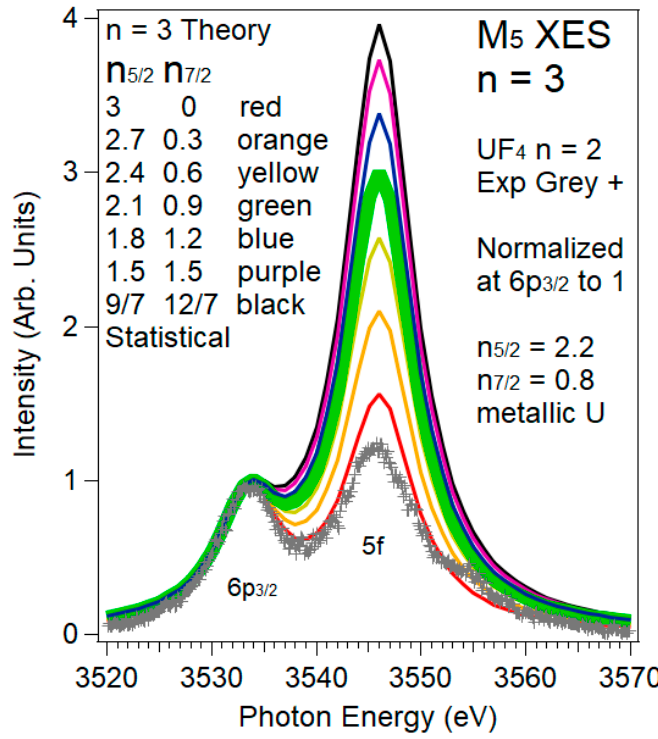
Figure 9. Shown here is the experimental M 5 XES spectrum of UF 4 and the simulated spectra for n = 3 and various values of n 5 / 2 . The simulation used normalized Lorentzian line shapes, with a half-width at half-max of Γ . For the 6p 3 / 2 , Γ = 3.5 eV. For the 5f peak, Γ = 4 eV.